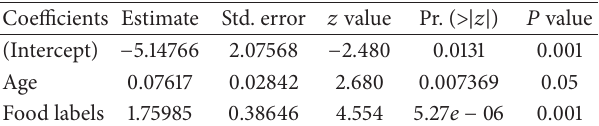
Table 4: Predictors of low sodium diet.